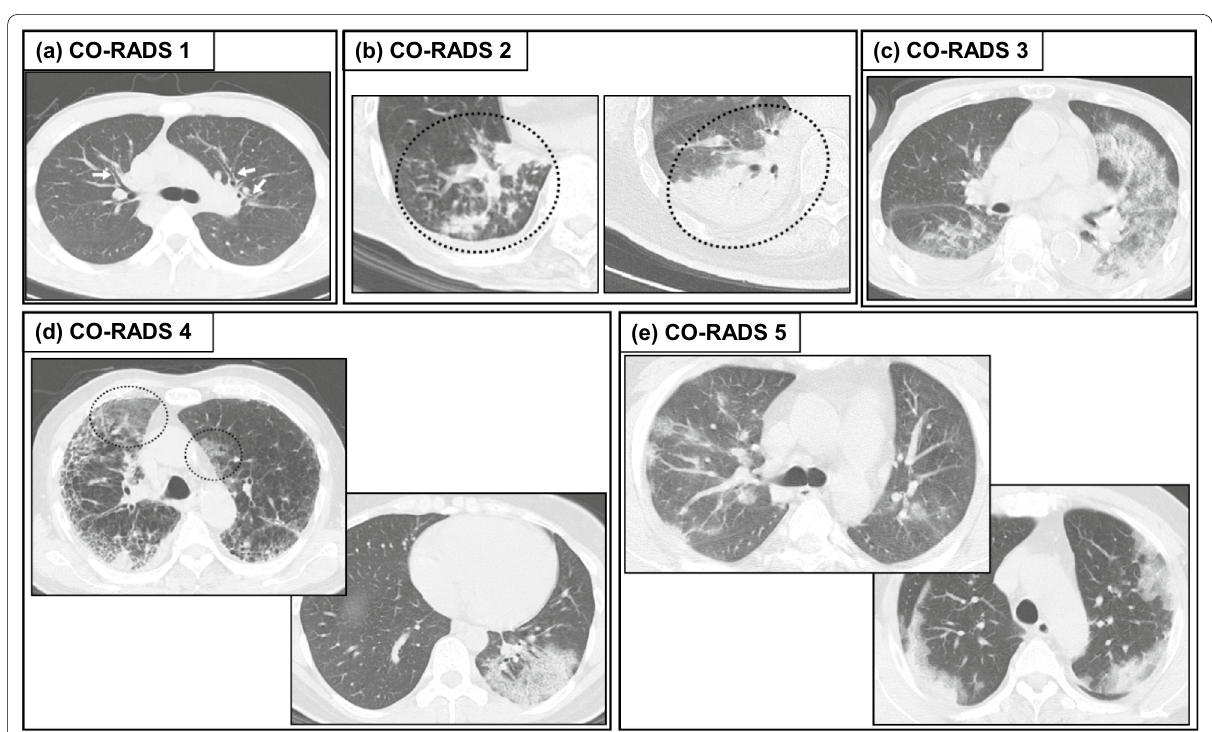
Fig. 2 Example of chest CT patterns of CO-RADS. Axial CT images are categorized as ( a ) CO-RADS 1, with no features of pneumonia, ( b ) CO-RADS 2, with features typical for infection other than COVID-19, e.g., bronchial pneumonia, lobar pneumonia, tuberculosis, or fungal infection, ( c ) CO-RADS 3, with features compatible with COVID-19 but also other diseases, e.g., alveolar pulmonary edema, ( d ) CO-RADS 4, with features suspicious for COVID-19 but with overlap with other diseases, drug-induced pneumonia or collagen disease-related lung diseases, and ( e ) CO-RADS 5, with typical pattern of COVID-19 pneumonia